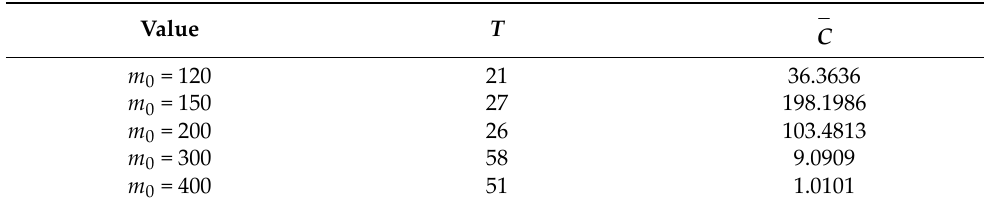
Table 3. Optimal results for different values of m 0 .